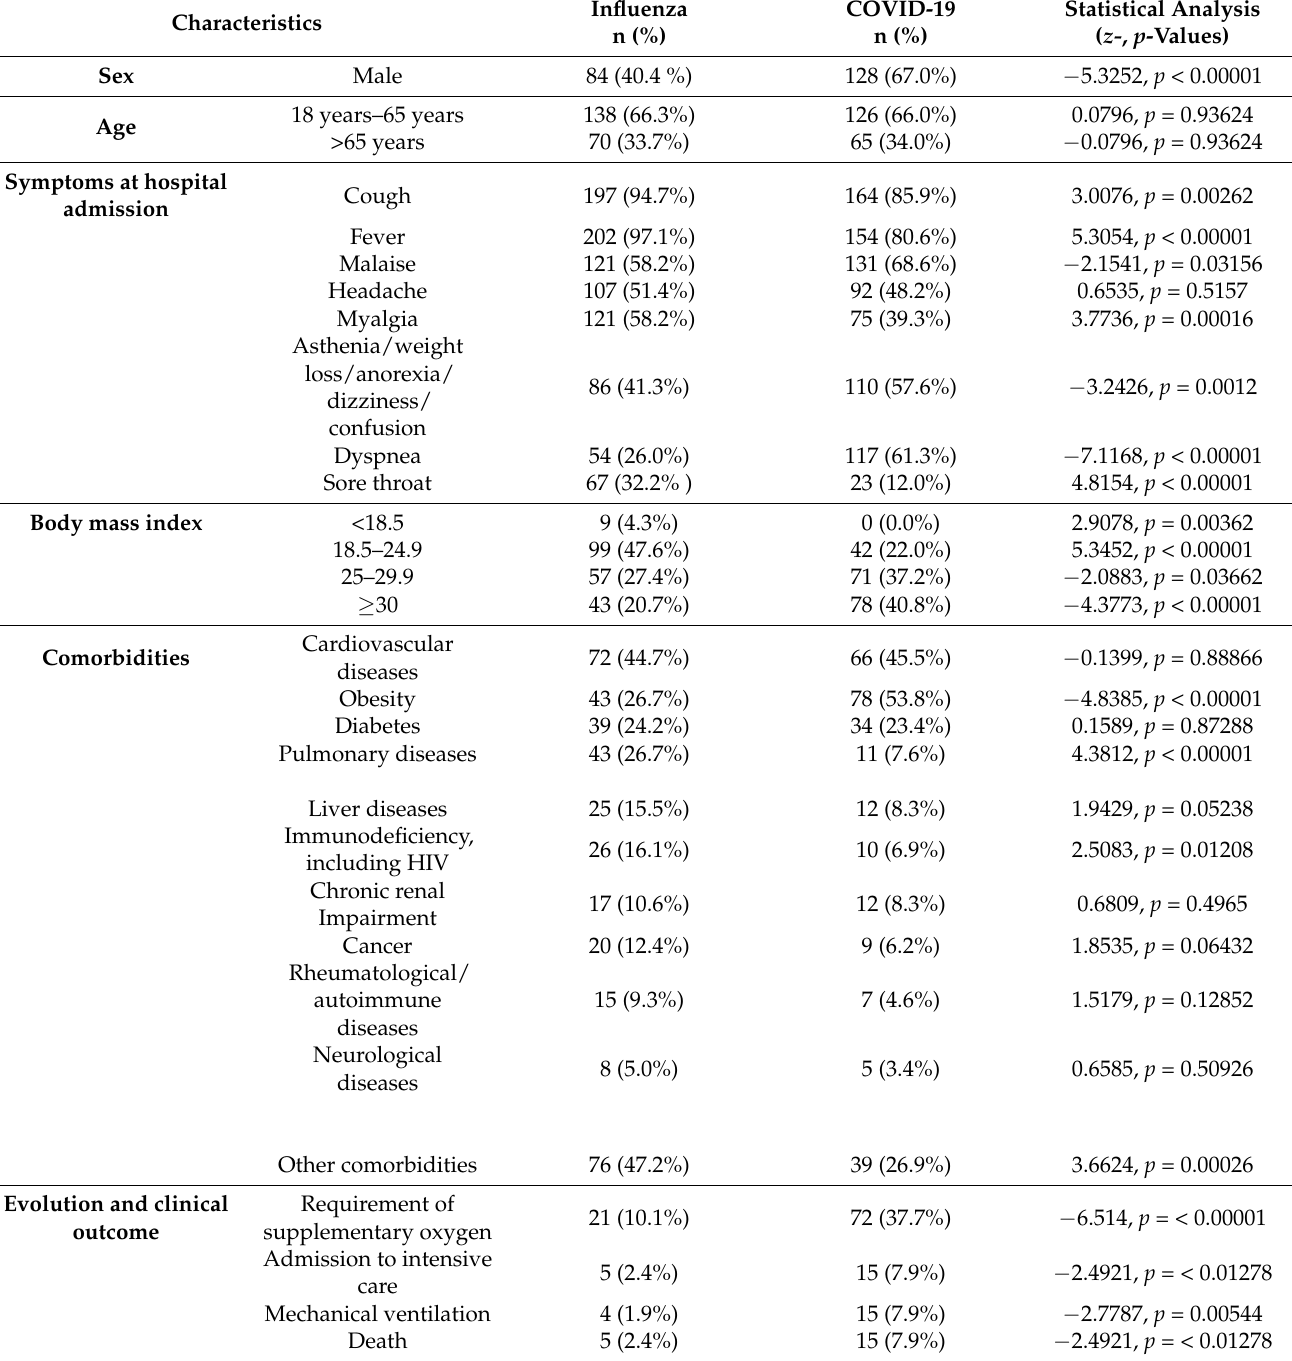
Table 1. Main characteristics of patients with influenza and